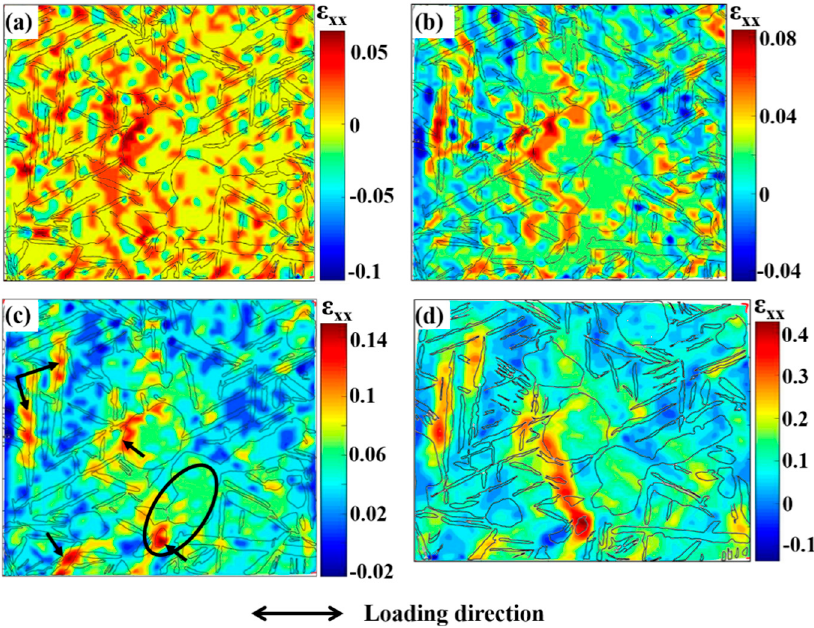
Figure 4. Axial strain maps at different tensile macro-strains: ( a ) 1.45%; ( b ) 2.77%; ( c ) 4.7%; ( d ) 12.75%.